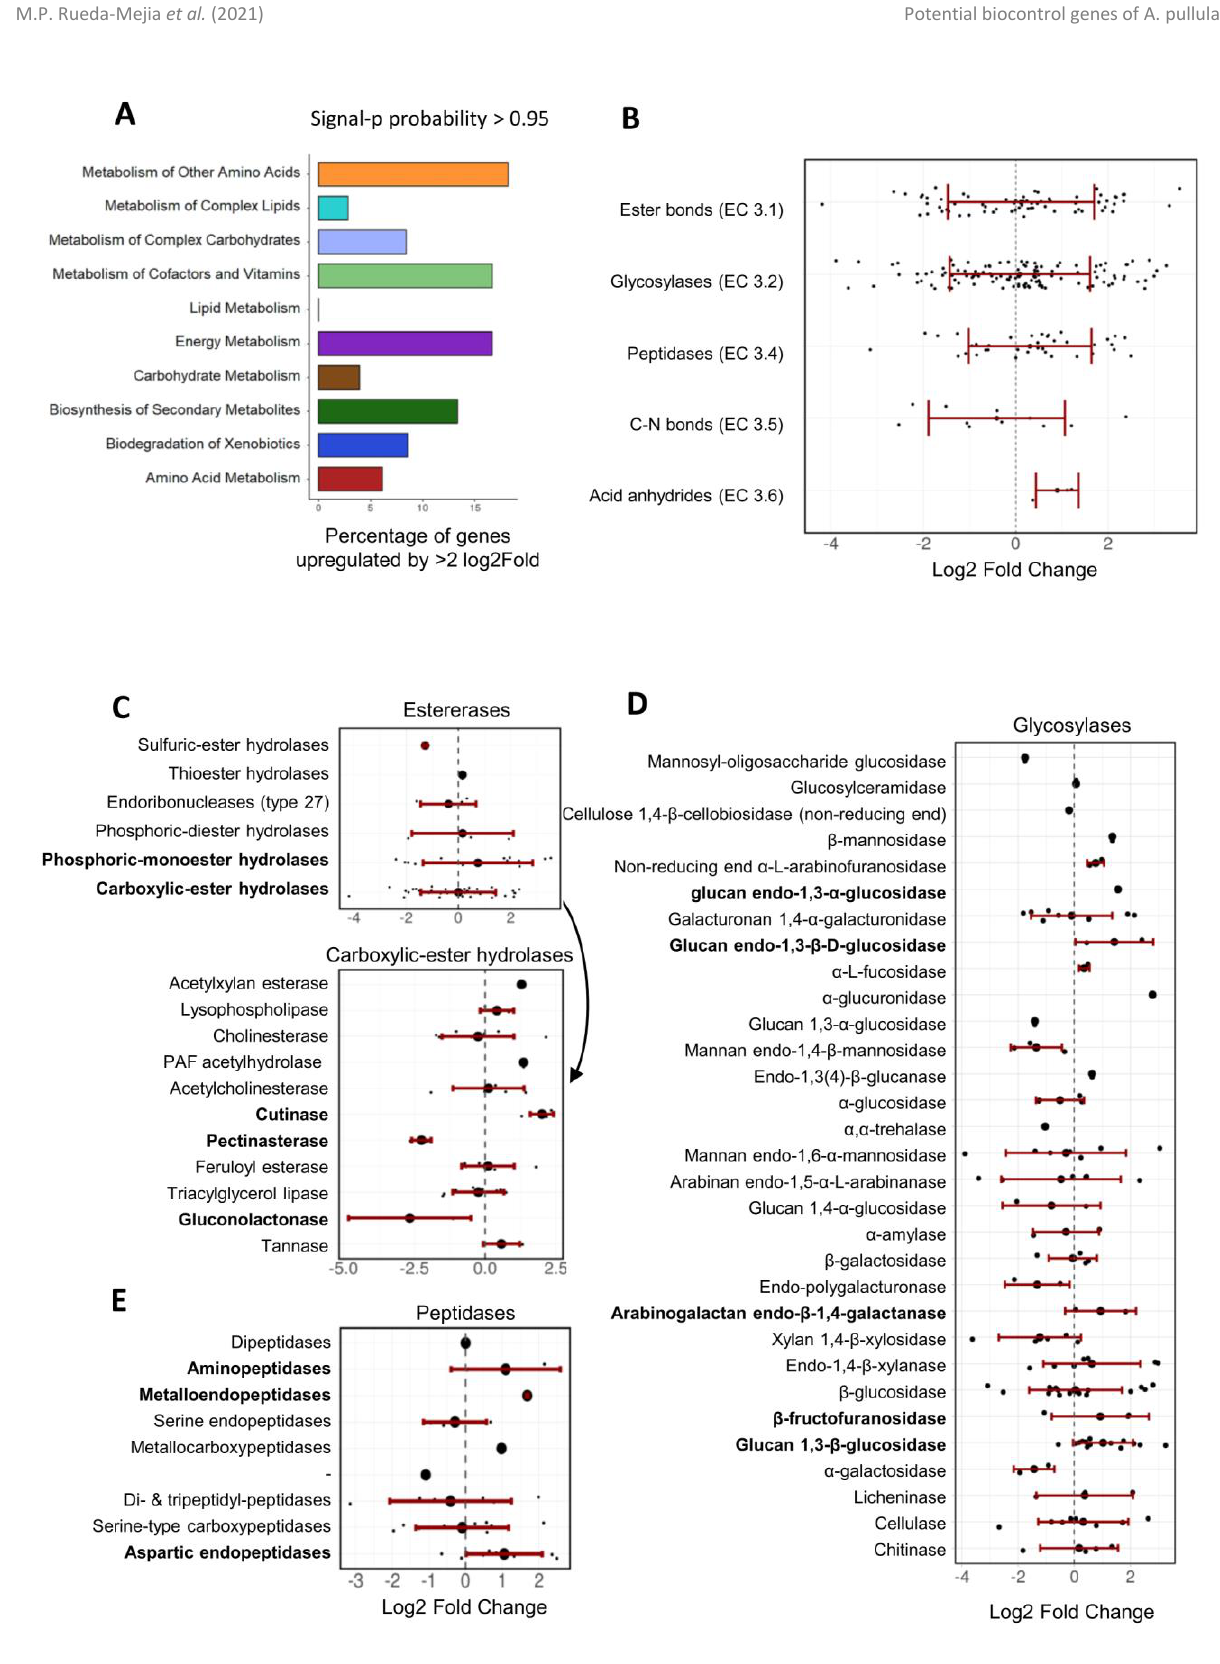
FIGURE 6 : Transcriptional regulation of A. pullulans NBB 7.2.1 genes with a predicted signal peptide upon co-cultivation with F. oxysporum NRRL 26381/CL57. Many A. pullulans NBB 7.2.1 hydrolase genes were strongly up- or downregulated during the interaction with F. oxysporum NRRL 26381/CL57. (A) Percentage of upregulated DEGs in each KEGG pathway class for those A. pullulans NBB 7.2.1 genes containing a predicted signal peptide. (B) Variation of the Log2 FC values within each hydrolase enzyme category. Variation of the Log2 FC values of all A. pullulans NBB 7.2.1 DEGs is also shown on a lower level of categorisation for hydrolases acting on ester bonds (C) , glycosylases (D) , and peptidases (E) OPEN ACCESS | www.microbialcell.com